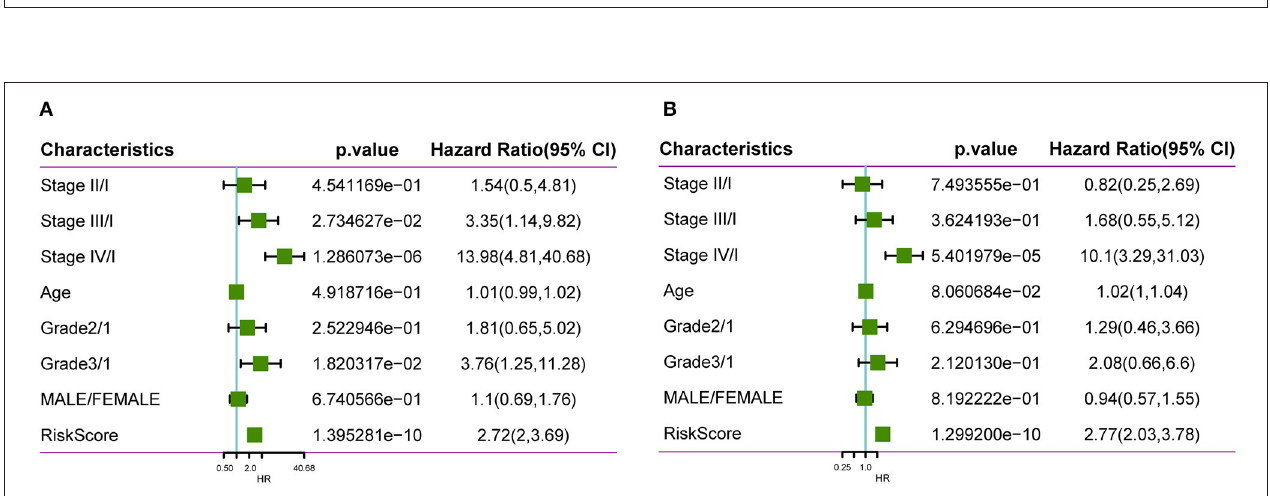
FIGURE 9 | Clinical independence of our constructed signature based on four oxaliplatin resistance-related genes. Univariate (A) as well as multivariate (B) Cox regression analysis on clinical data and risk score from the training set was employed to calculate the corresponding HRs, 95% CIs, and P -values.